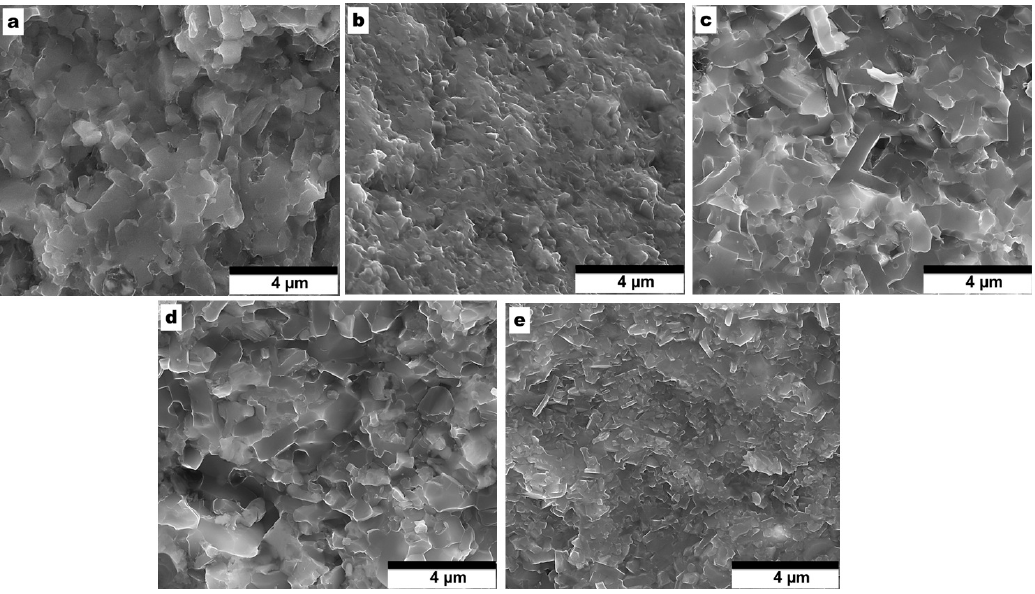
Figure 7. Fracture surfaces of RSPSed samples ( a ) Zr-B; ( b ) 75Zr-25Ti-B; ( c ) 50Zr-50Ti-B; ( d ) 25Zr-75Ti-B; and ( e ) Ti-B.